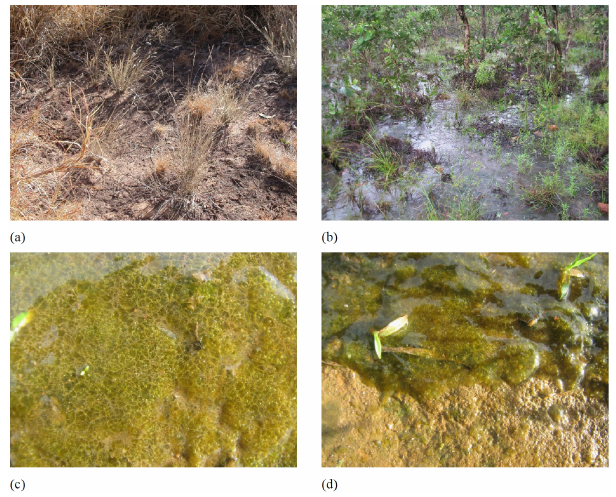
Figure 3. Seasonal cyanobacterial crust functions: (a) dry cyanobacterial crust, (b) flooded crust at the commencement of heavy rains in January, (c) rapid regrowth with extracellu- lar polysaccharide (EPS) hyperproduction from Nostoc sp. and (d) gelatinous EPS during hyperproduction phase compared with bare area being